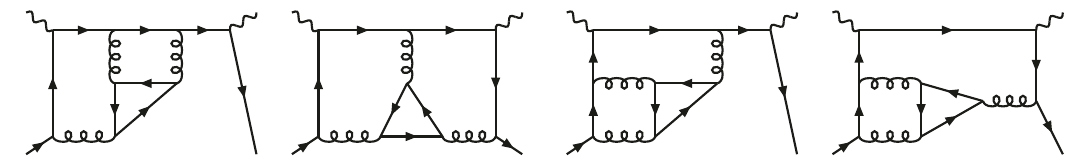
contributions to the third-order coefficient f C n 2 terms, since only two-loop diagrams F A f